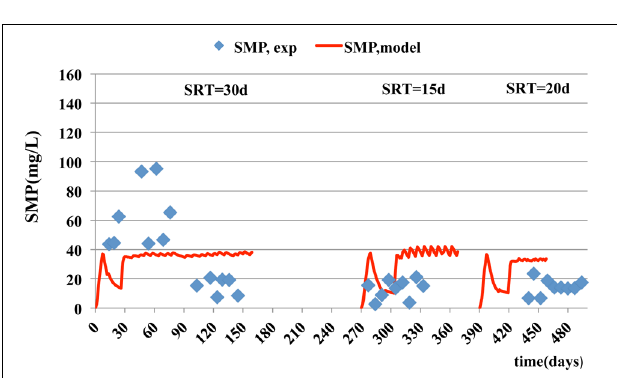
FIGURE 6 | Experimental data and model estimations of soluble EPS (SMP) concentration.